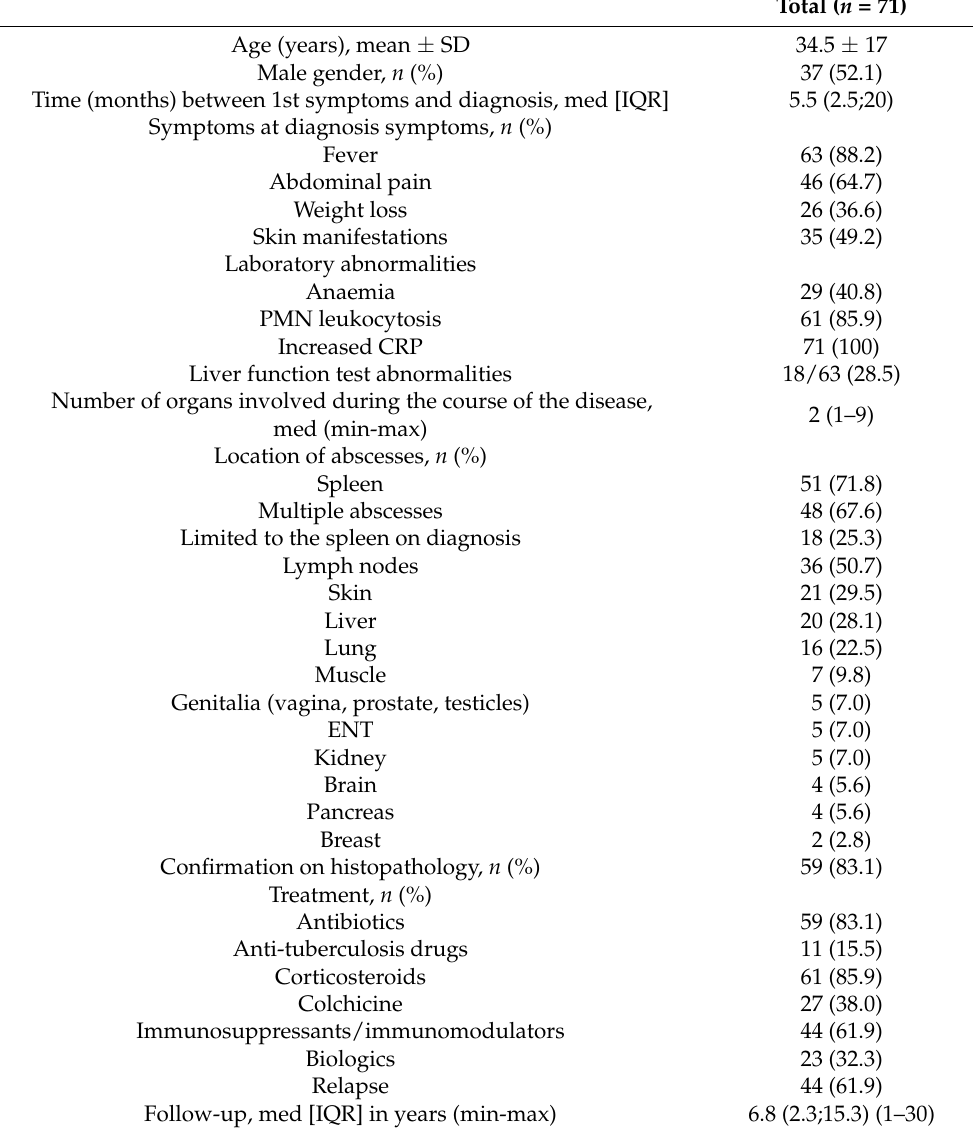
Table 1. Characteristics of 71 patients presenting with aseptic abscess